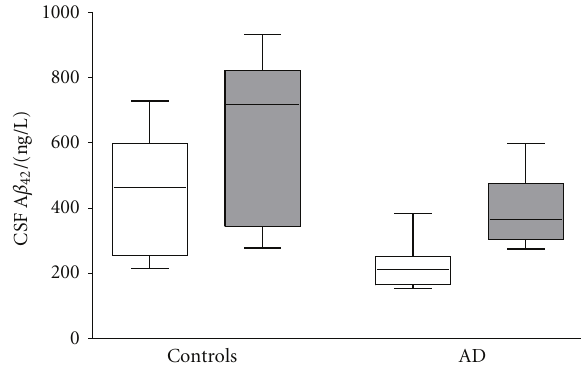
Figure 3: Boxplot (whiskers represent minutes and max values) of measured concentrations of A β 42 in untreated and heat denatured CSF. The white boxes represent untreated CSF and dark boxes represent heat denatured CSF. Each box represents 15 samples (15 AD or 15